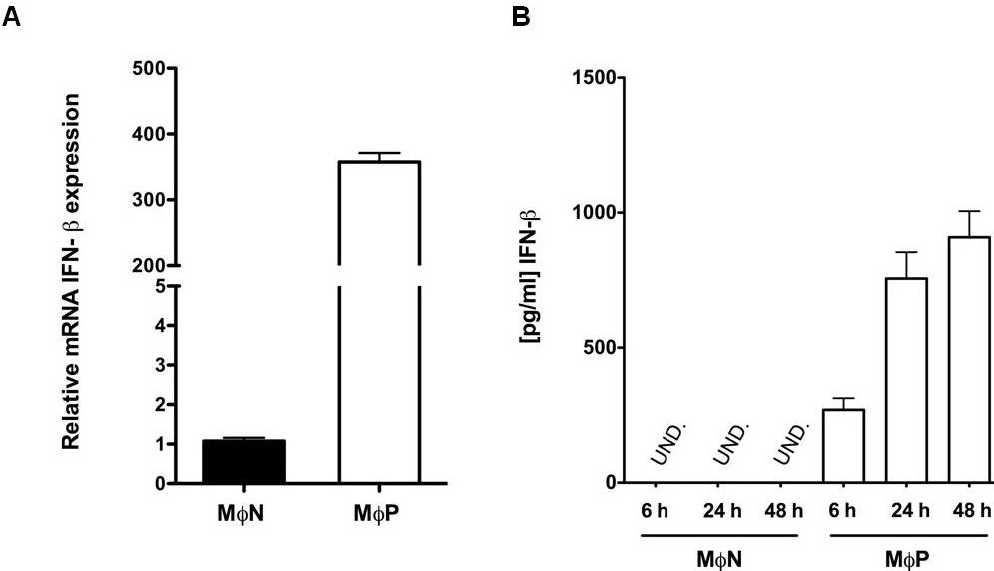
Figure 3. Expression of interferon-β (IFN-β) mRNA and protein in persistently RSV-infected macrophages. ( A ) Quantitative RT-PCR was performed with three different passages of non-infected macrophages (MΦN) and of persistently RSV-infected macrophages (MΦP), all cultured for 24 h, to determine the mRNA expression level of IFN- β by the ΔC t method. The values from the three different passages were averaged and plotted as relative expression of mRNA IFN- β; ( B ) Quantitative analysis by ELISA of the expression of IFN-β protein in supernatants of MΦN and MΦP cultured for 6, 24, and 48 h. UND: undetected. IFN-β mRNA and protein expression were evaluated in passages 93, 95 and 96 of MΦN and 92, 93 and 94 of MΦP. Results were reproduced in six cellular passages analyzed (biological replicates).